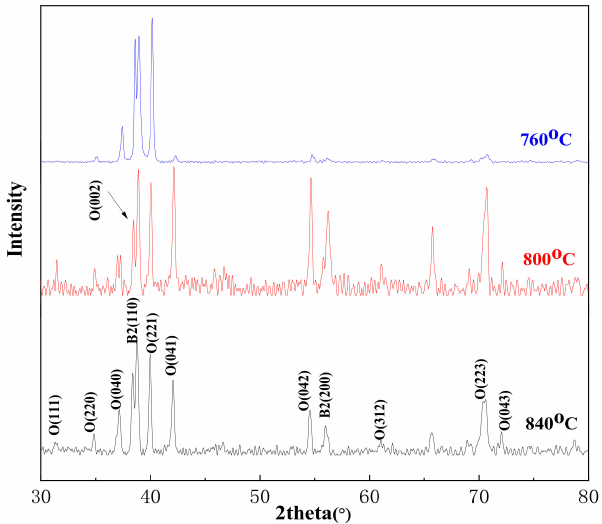
Figure 11. X-ray diffraction peaks of weld zone under different aging treatment conditions. Table 4. Volume fraction of α 2 , O, and B2 phase for weld zone under different aging conditions.